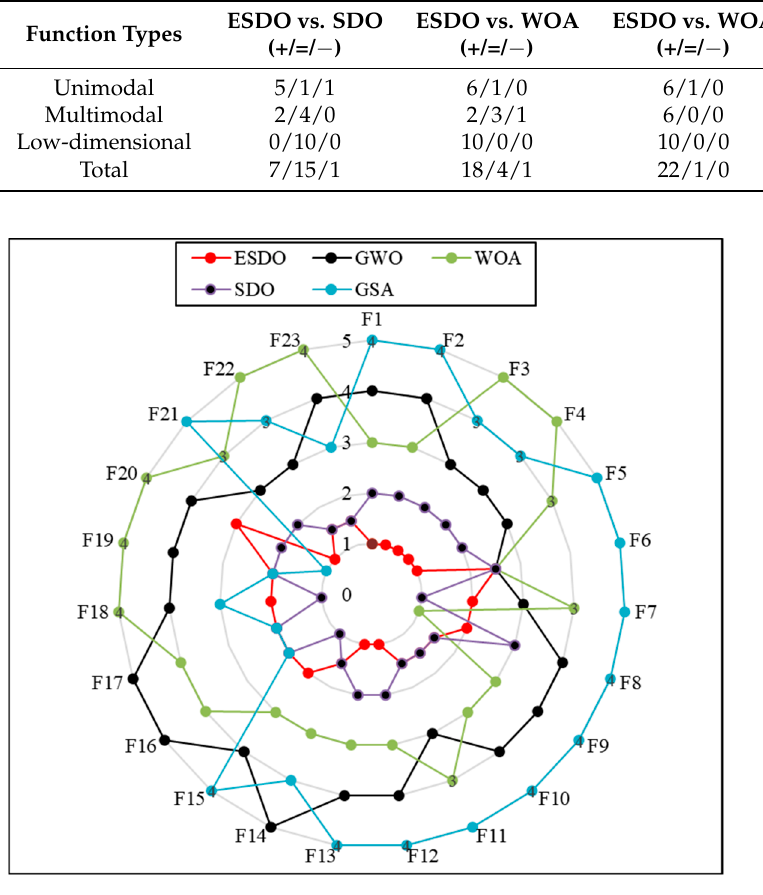
Figure 6. Ranks of different algorithms for each function.